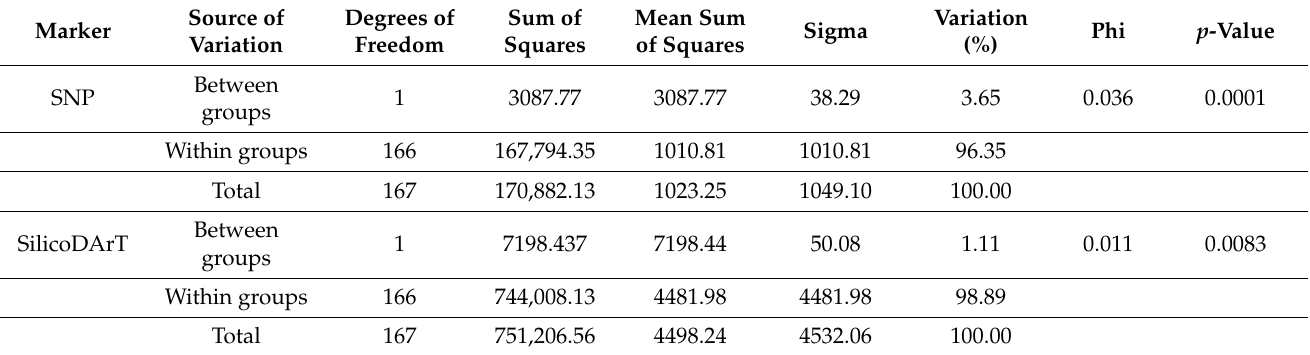
Table 6. AMOVA result between the subset and the rest of the